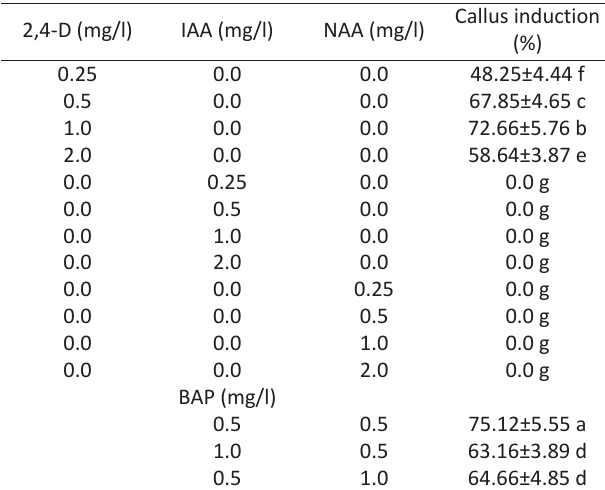
Table 1 - Callus induction frequency in Gladiolus . Corm explants was cultured on MS medium, added with 2, 4-D,